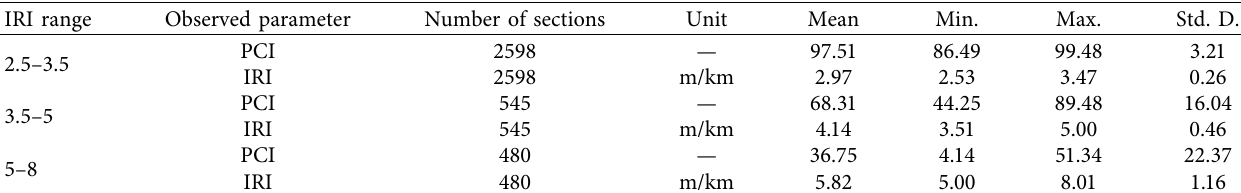
Table 2: Range of international roughness index and pavement condition index and associated parameters. IRI range Observed